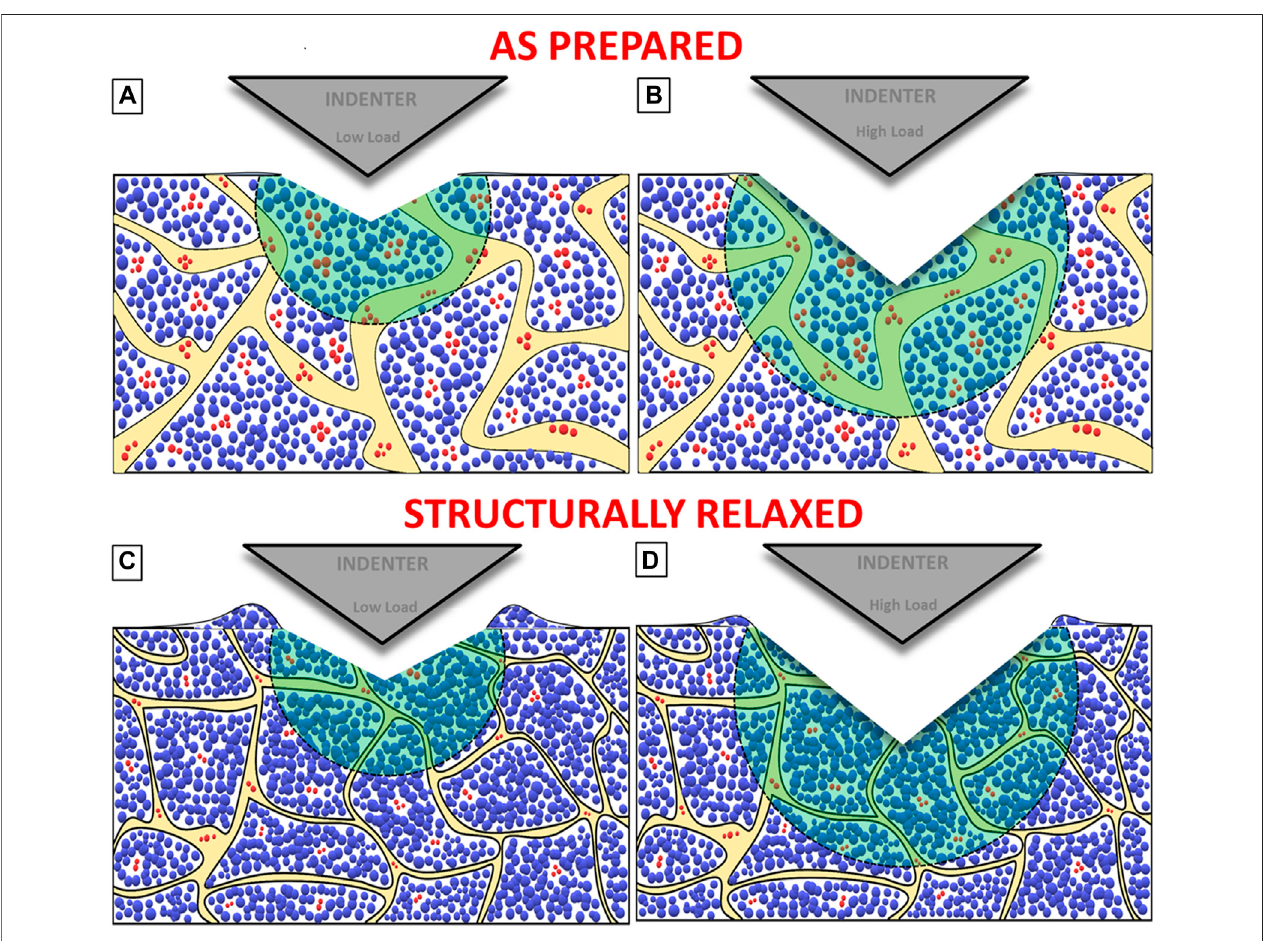
FIGURE 10 | Schematic illustrating the differences in microstructure and deformation morphology between AP and SR NGs. (A, B) represents the deformation morphology at low and high indentation loads of AP NGs, respectively, while (C, D) for low and high indentation loads for SR NGs, respectively.